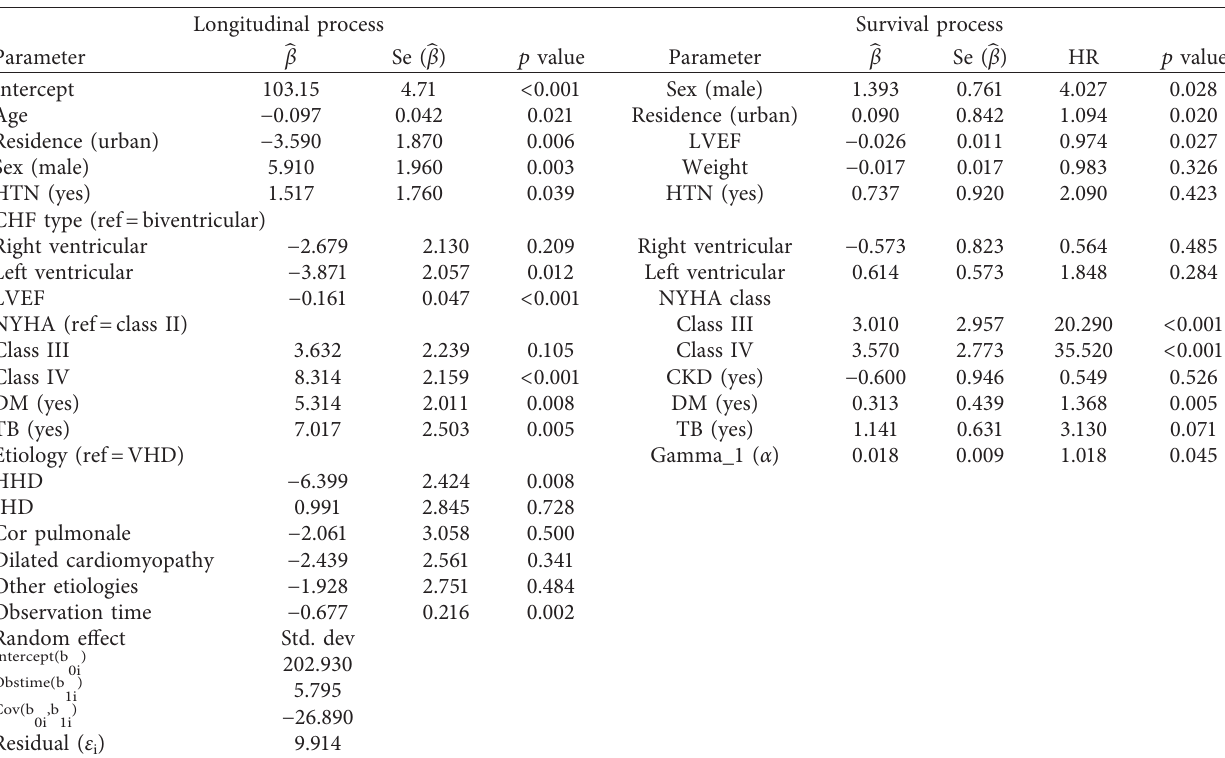
CHF � congestive heart failure, CKD � chronic kidney disease, DM � diabetes mellitus, HHD � hypertensive heart disease, HTN � hypertension, IHD � ischemic heart disease, LVEF � left ventricular ejection fraction, NYHA � New York Heart Association, PR � pulse rate, Ref � reference category, Se � standard error, TB � tuberculosis, and VHD � valvular heart